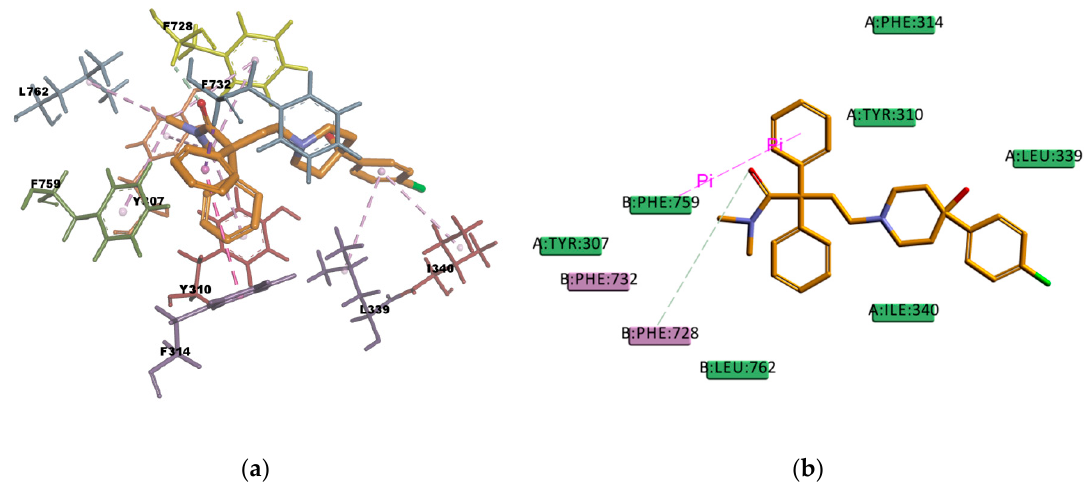
Figure 15. Loperamide (LMP) top-ranked pose obtained with CDOCKER algorithm. ( a ) 3D view of LMP interactions in the binding pocket. Light-green dotted lines represent carbon hydrogen bond interactions, light-rose dotted lines represent hydrophobic interactions, and the pink dotted line represents a π – π interaction. Residue F728 involved in a carbon hydrogen bond interaction is highlighted in yellow; ( b ) 2D interaction diagram of LMP with h P-gp interacting residues. The light-green dotted line represents a carbon hydrogen bond interaction, and the pink dotted line represents a π – π interaction with residue the F759.